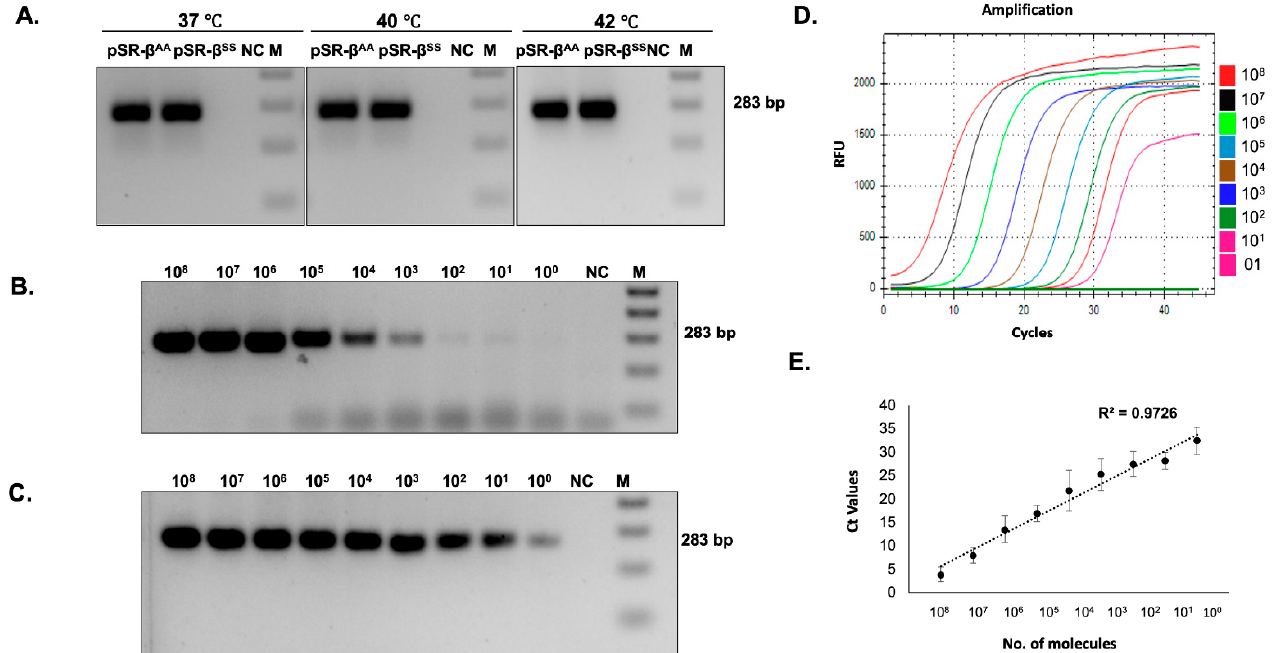
Figure 2. Optimization of iDA using recombinant plasmids. ( A ) iDA of recombinant plasmids pSR- β AA (WT) and β SS (MT) at different temperatures. ( B ) Minimum copy number required for iDA. ( C – E ) qRT-PCR for n = 3. Table 1. A comparative analysis of different lysis buffers for iDA.